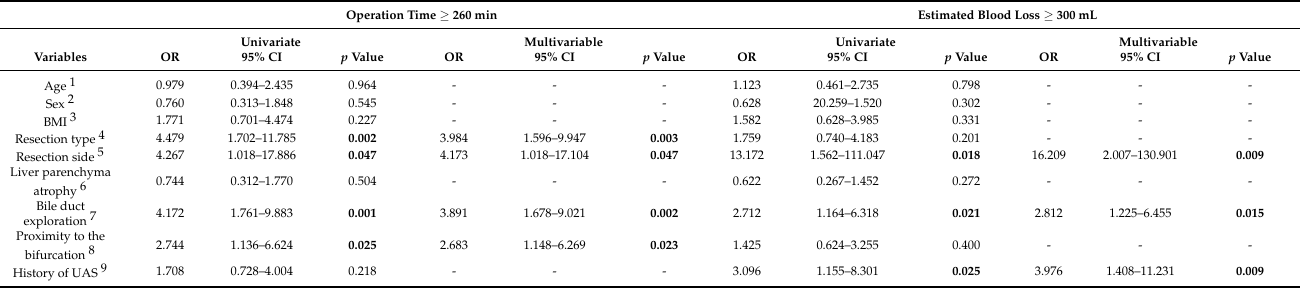
Table 3. Logistic regression analysis for operation time ≥ 260 min and estimated blood loss ≥ 300 mL as the dependent